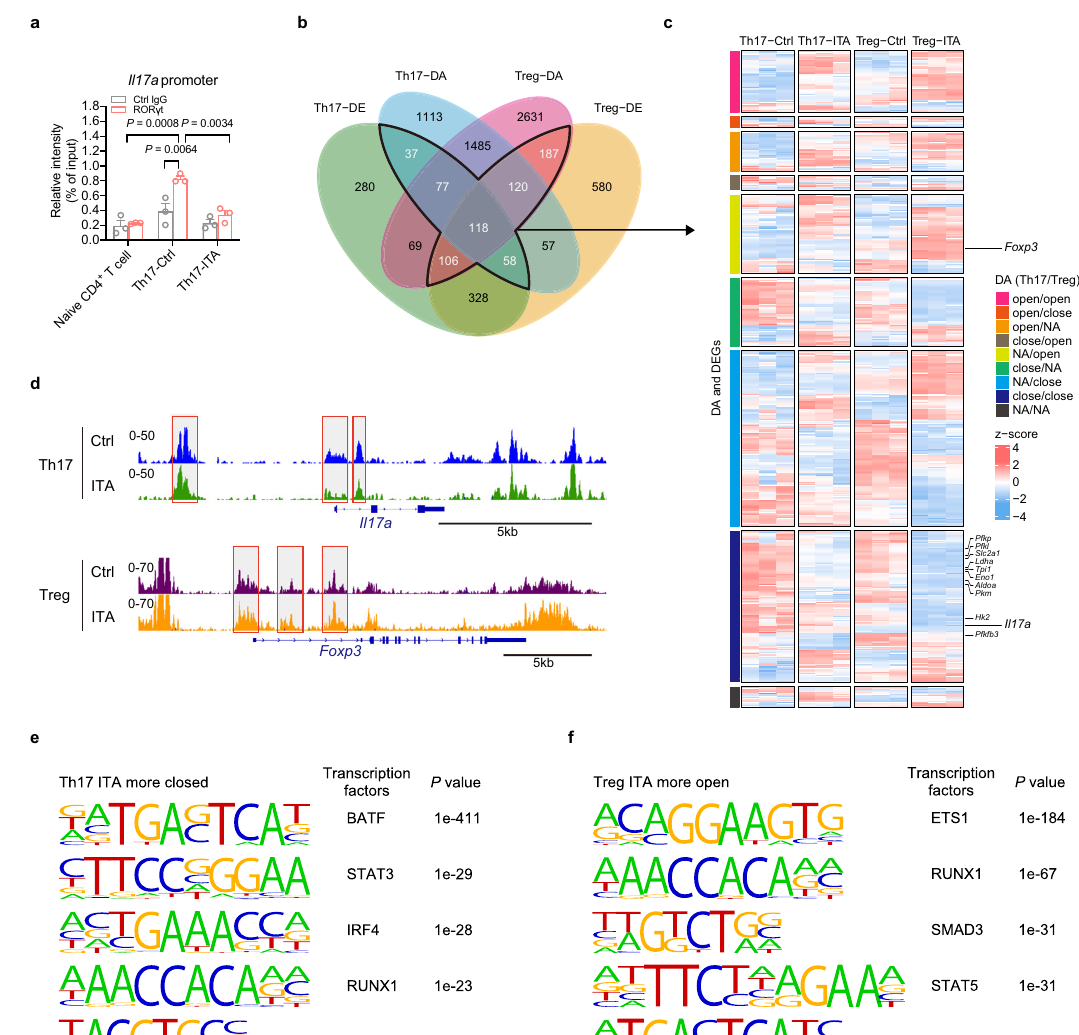
Fig. 6 | Itaconate altered the chromatin accessibility of essential transcription factors in Th17 and Treg cell differentiation. a Chromatin immunoprecipitation (ChIP) analysis of ROR γ t at the Il17a promoter regions in naive CD4 + and Th17- polarizing T cells in the presence or absence of itaconate (ITA) (Naive CD4 + , n =3; Th17, n =3). b – f Assay for transposase-accessible chromatin sequencing (ATAC- seq) was performed using Th17- and Treg-polarizing T cells from B6 mice in the presence or absence of ITA after 2 days of culture. Two replicates ( n =2, each group) were used for ATAC-seq. Venn diagram displaying the overlap between DEGs between ITA-treated and control T cells under Th17 or Treg conditions and between genes that show differential chromatin accessibility (DA) ( b ). Heatmap